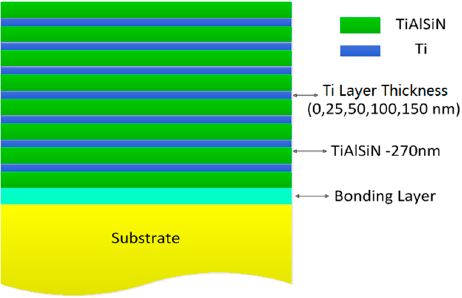
Figure 2. The schematic drawing for TiAlSiN / Ti multilayer coatings. The number of TiAlSiN and Ti sublayers is eight and seven, respectively.